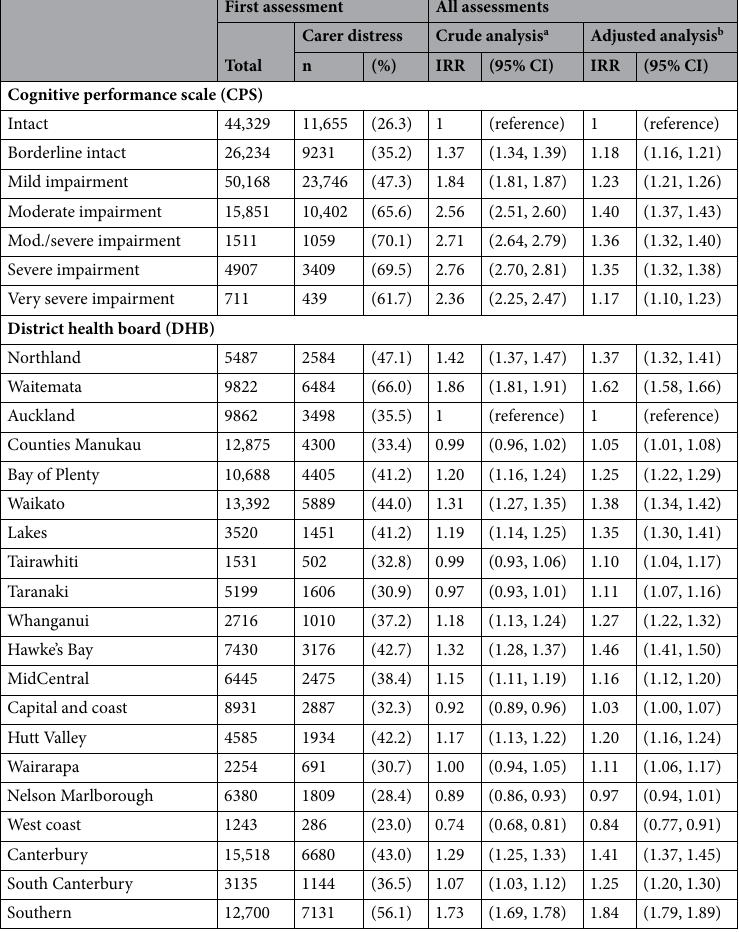
Table 2. Distribution of carer distress indications for participants’ sociodemographic and selected health measures at the first assessment, together with estimated relative risks (RRs) and associated 95% confidence intervals (CIs) estimated from the crude and adjusted multilevel mixed-effects Poisson models. a Adjusted for time 2 , time 3 , and COVID indication. b Adjusted for all variables contained within Table